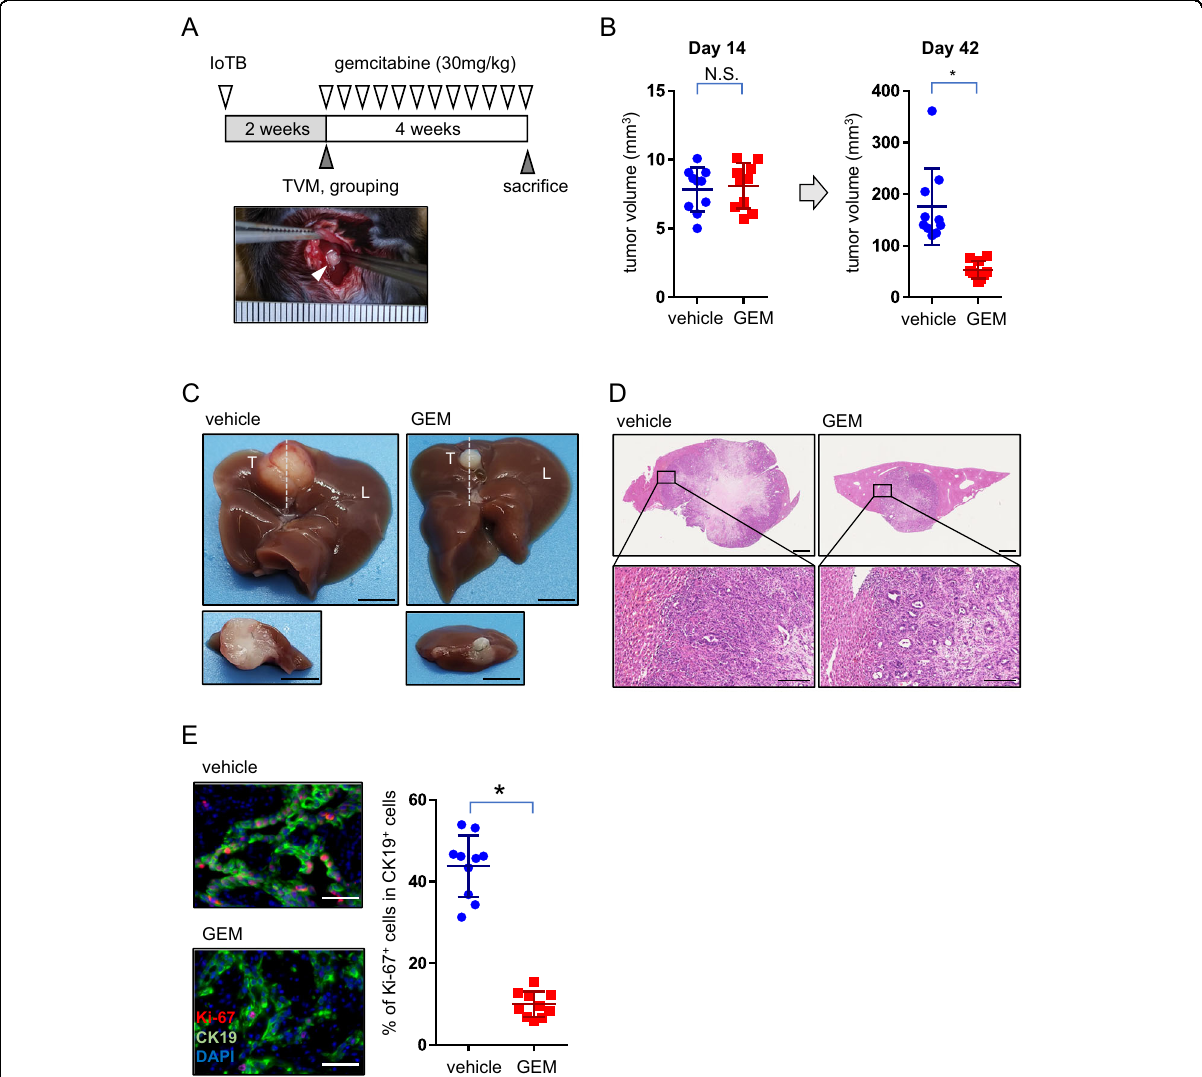
Fig. 6 Chemotherapeutic treatment in orthotopic and syngeneic gall bladder (GB) cancer model. A A scheme of chemotherapeutic treatment. TVM tumor volume measurement. An inspected tumor is shown (open arrowhead). B The tumor volumes in vehicle- ( n = 10) or gemcitabine-treated groups ( n = 10) on day 14 and 42 after IoTB. N.S., not signi fi cant. * p < 0.0001. c Macroscopic fi ndings of the treated tumors. Representative images are shown. T tumor, L liver. Dashed lines (upper panel) indicate the cut surface of the tumors (lower panel). Scale bar, 5 mm. D Microscopic features of the tumors. Representative images of hematoxylin and eosin (H&E) staining are shown. Upper panel, whole images of the tumors. Scale bar, 1 mm. Lower panel, invasion front adjacent to the liver. Scale bar, 0.1 mm. E The proportion of Ki-67 + proliferating cells among CK19 + epithelial cells in each group. Left, representative images of immunostaining. Cell proliferation (red, Ki-67), epithelial cells (green, CK19), and the nucleus (blue, DAPI) are visible. Scale bar, 50 μ m. Right, summary of the results. * p =